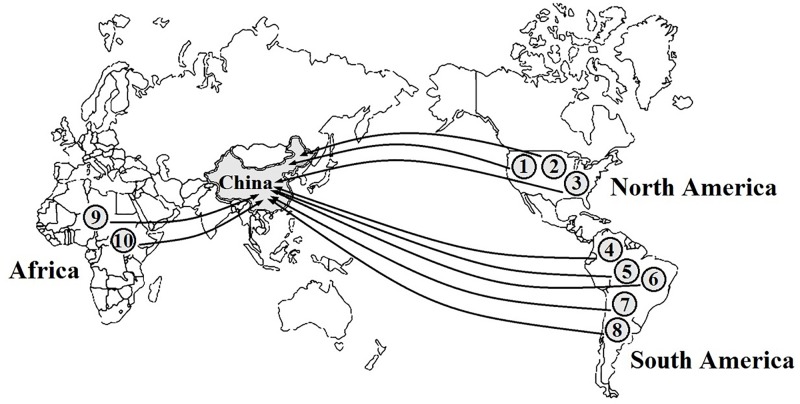
Geographical origins of 10 major aquatic invasive plants in China. Data are from the announcements of “Inventory of Invasive Species in China (first–fourth volumes)” which were enacted by the Ministry of Ecology and Environment of China & Chinese Academy of Sciences (2003, 2010, 2014, 2016) (http://www.mee.gov.cn/) and some published literatures (Ding et al., 2008; Yan et al., 2014; Wang et al., 2016). Latin names of species code in this figure are Cabomba caroliniana (1), Spartina alterniflora (2), Hydrocotyle vulgaris (3), Azolla filiculoides (4), Alternanthera philoxeroides (5), Myriophyllum aquaticum (6), Eichhornia crassipes (7), Pistia stratiotes (8), Brachiaria brizantha (9), and Brachiaria mutica (10).